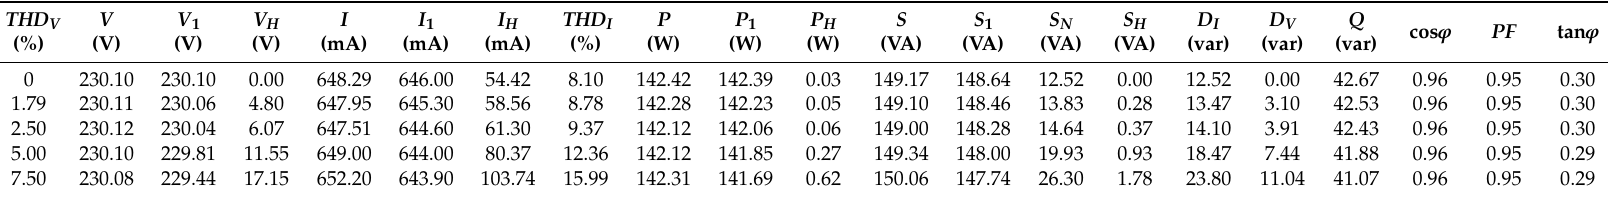
Table 5. Summary of measured and calculated values of electrical parameters of the LED1 luminaire at a change in the level of deformation of the supply voltage.